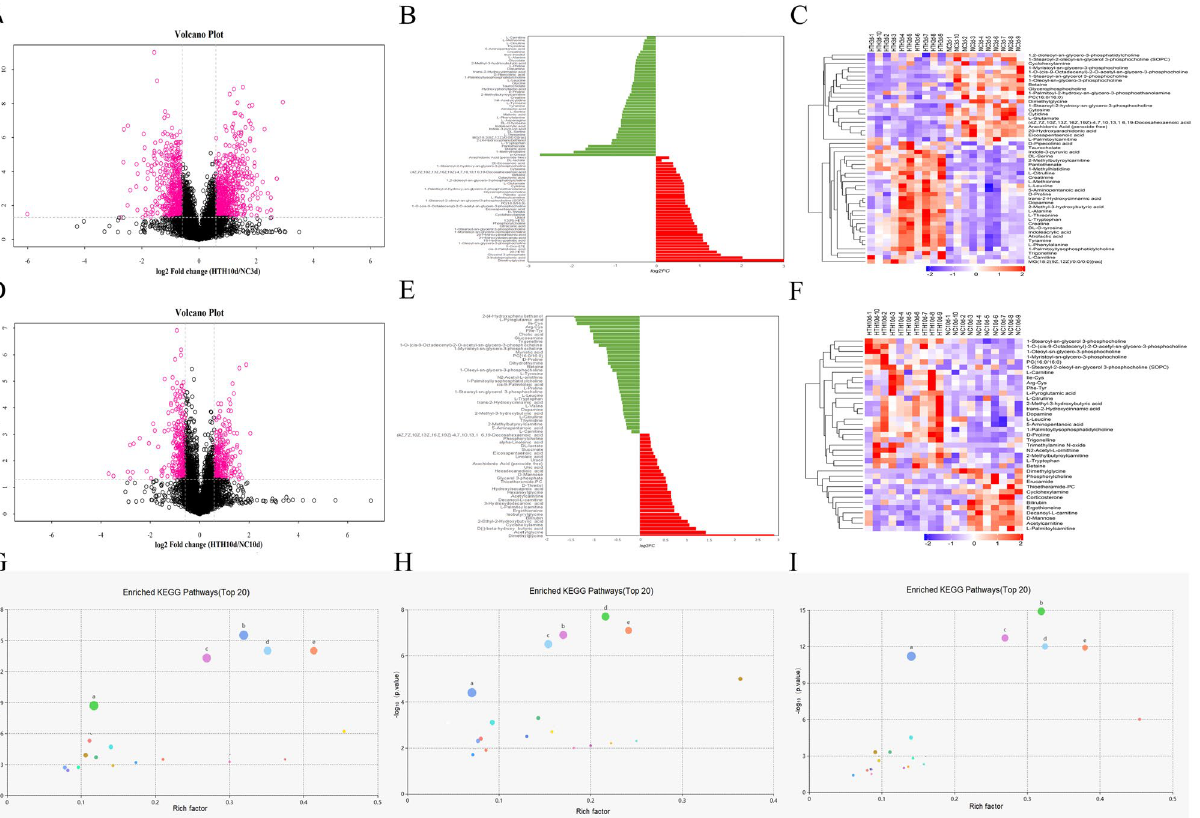
Figure 2. Screening and changing characteristics of various metabolites in plasma exposed to HTH environment at different times. The volcano graph shows the difference in metabolites of HTH3d_vs_NC3d ( A ) and HTH10d_vs_NC10d ( D ). The red dots in the figure are the metabolites with FC > 1.5 and p value < 0.05, which are the differential metabolites screened by univariate statistical analysis. Linear discriminant analysis (LDA) analyzes the size of the differential metabolites between HTH3d_vs_NC3d ( B ) and HTH10d_vs_NC10d ( E ). Hierarchical clustering heat map analysis of differential metabolites between HTH3d_vs_NC3d ( C ) and HTH10d_vs_NC10d ( F ). Each column represents a sample, and each row represents a metabolite. The color of each part corresponds to the concentration value of each metabolite calculated by the peak area normalization method (red, up; blue, down). ( G , H , I): KO enrichment analysis bubble chart of metabolic pathways: a. ABC transporters; b. Protein digestion and absorption; c. Aminoacyl-tRNA biosynthesis, d. Central carbon metabolism in cancer, e. Mineral absorption. G: HTH3d_vs_NC3d group; H: HTH10d_vs_NC10d group; I: HTH10d_vs_HTH3d